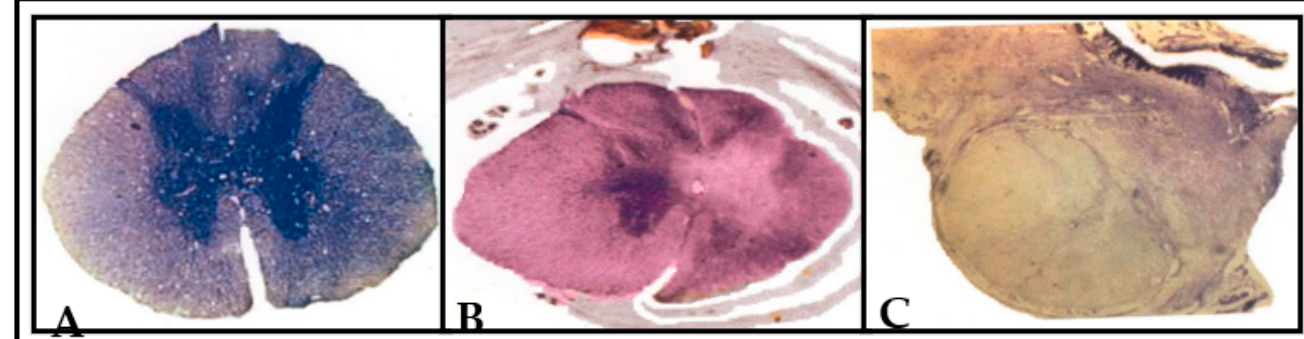
Figure 9. Photographs showing the Nissl (cresyl fast violet)-stained sections of spinal cord of the ( A ) normal animal, ( B ) unilateral spinal-hemisected animal (pop 360 days) and ( C ) peripheral nerve-transplanted animal (pop 360 days). In ( A ), the arrangement of gray and white matter is clearly differentiated in both right and left side of normal spinal cord section. In ( B ), a typical hemisection lesion cavity is viewed in the right side of spinal cord section. The lesion included the total damage of gray and white matter in right side of spinal cord section. The hemisection lesion caused the section to be deformed into an irregular shape of surrounding tissue in right side (indicated by an arrow). This section was at the maximal extent of lesion. The unlesioned left side was found intact, and no serious changes in the arrangement of gray and white matter were noted. In ( C ), the transplanted predegenerated nerve fascicles were found to be interlinked with the unlesioned left side of spinal cord. A black arrow indicates the transplanted predegenerated tissue in right side of lesioned spinal cord.